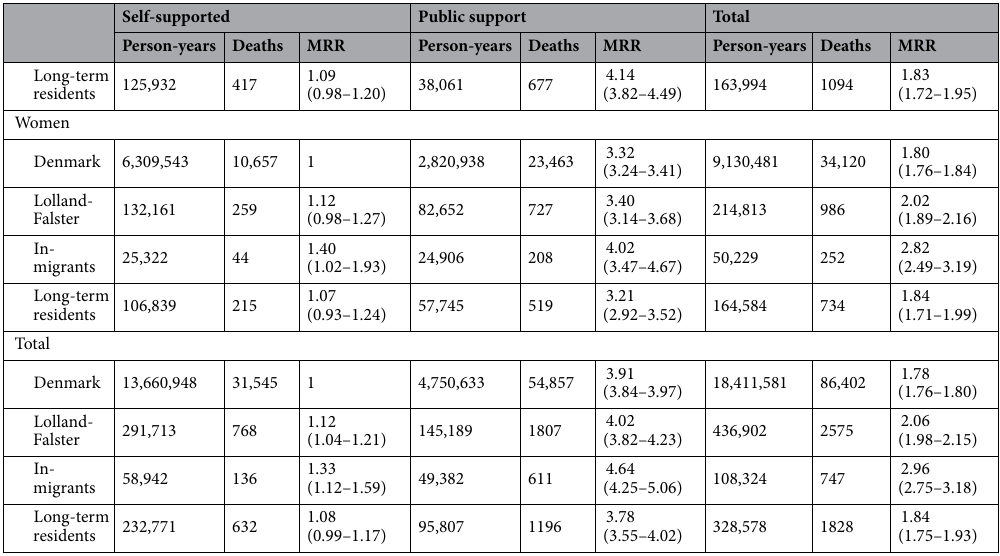
Table 2. Person-years, number of deaths and mortality rate ratio for people aged 30–64 years in Lolland- Falster by residency group, economic status, sex, and time-period. Mortality rate ratios were adjusted for 5-year age-groups and sex. Self-supported in rest of Denmark is the reference population.